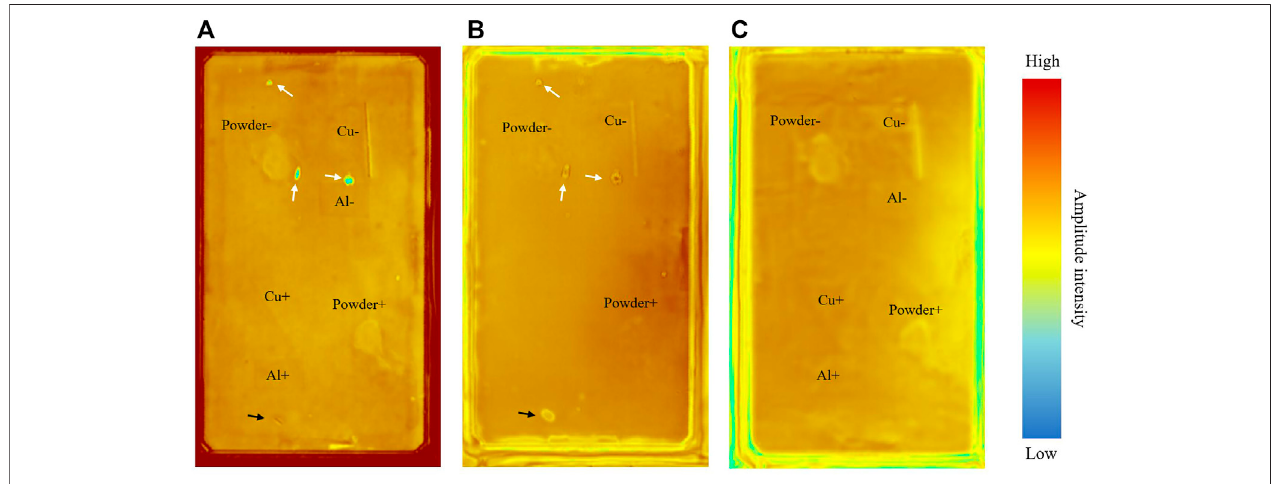
FIGURE 5 | Transmission C scan (A) , re fl ection C-scan in front side (B) and rear side (C)